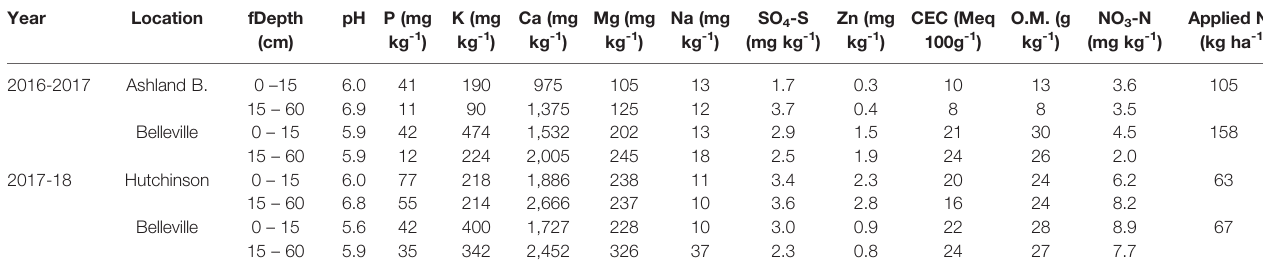
TABLE 1 | Initial soil pH in water, extractable P, K, Ca, Mg, Na, SO 4 -S, Zn, cation exchange capacity (CEC), organic matter (O.M.), and NO 3 -N for the 0 – 15 and 15 – 60 cm soil layers at Ashland Bottoms, Belleville and Hutchinson,